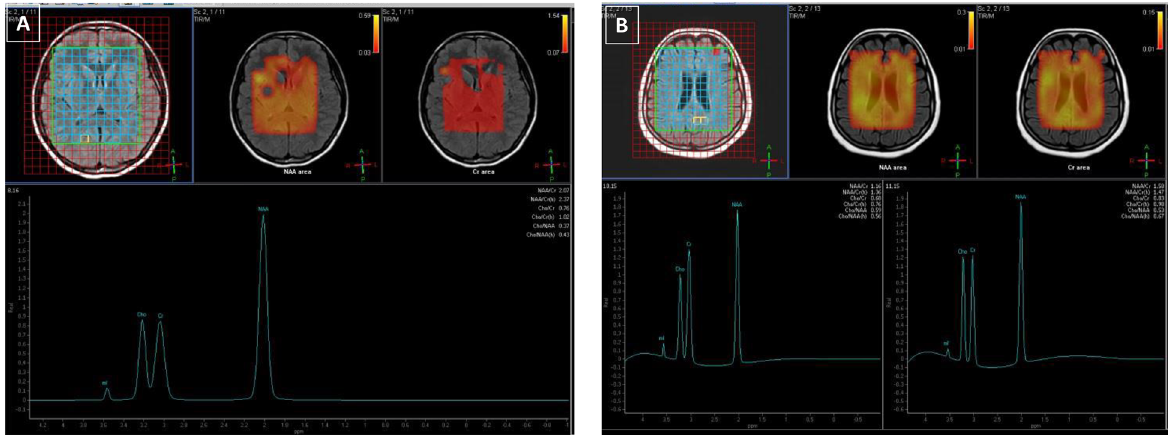
Fig. 2 Brain MR spectroscopy in SLE patients with A inactive disease and B active